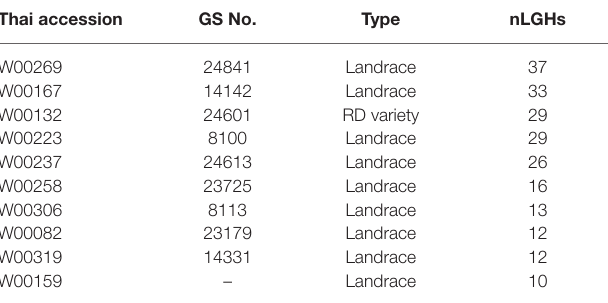
TABLE 2 | Table of individual accessions featuring more than ten large grain size-associated haplotypes (LGHs) found among Thai NFV accessions but not ECs across all 12 rice genome chromosomes. See Supplementary Table S5 for full